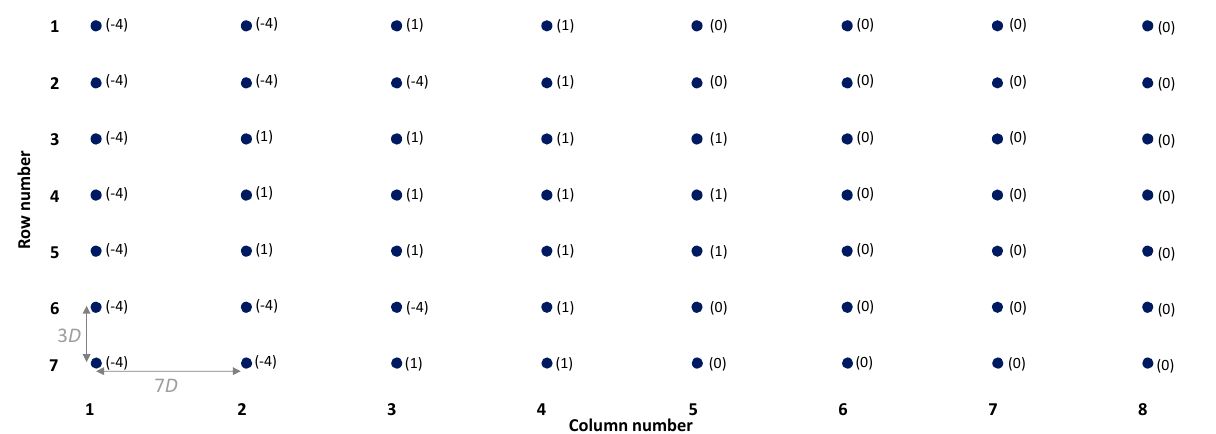
Figure 5. Layout of the wind farm under study and pitch of each wind turbine (in brackets) obtained by means of the optimisation strategy proposed in this work.